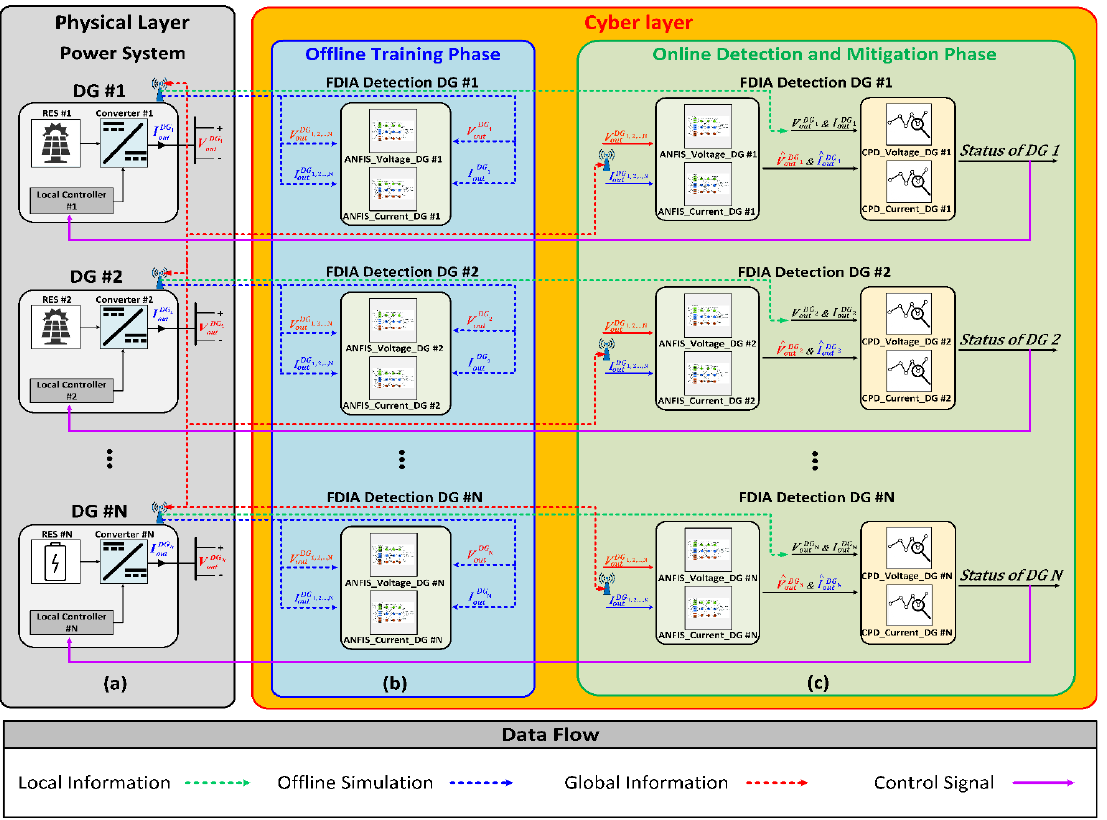
Figure 2. Proposed FDIA detection and mitigation framework: ( a ) Physical power system, ( b ) Offline training phase implementation, ( c ) Online FDI detection and mitigation phase.